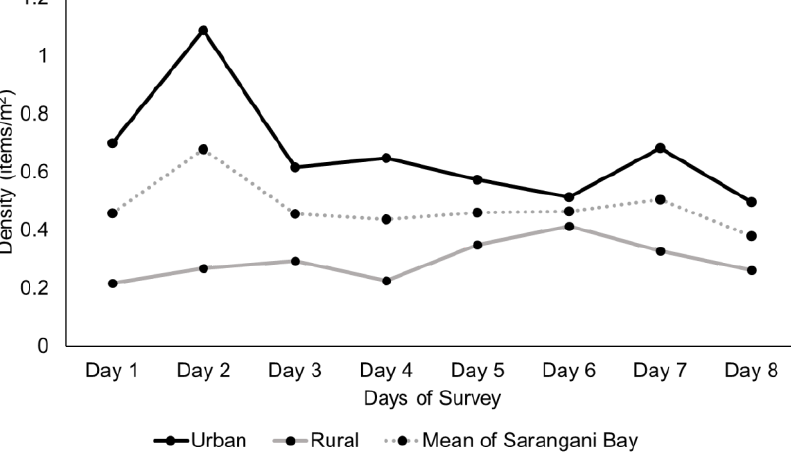
Figure 4. Temporal pattern of total plastic items collected in urban and rural beach areas for eight non-consecutive